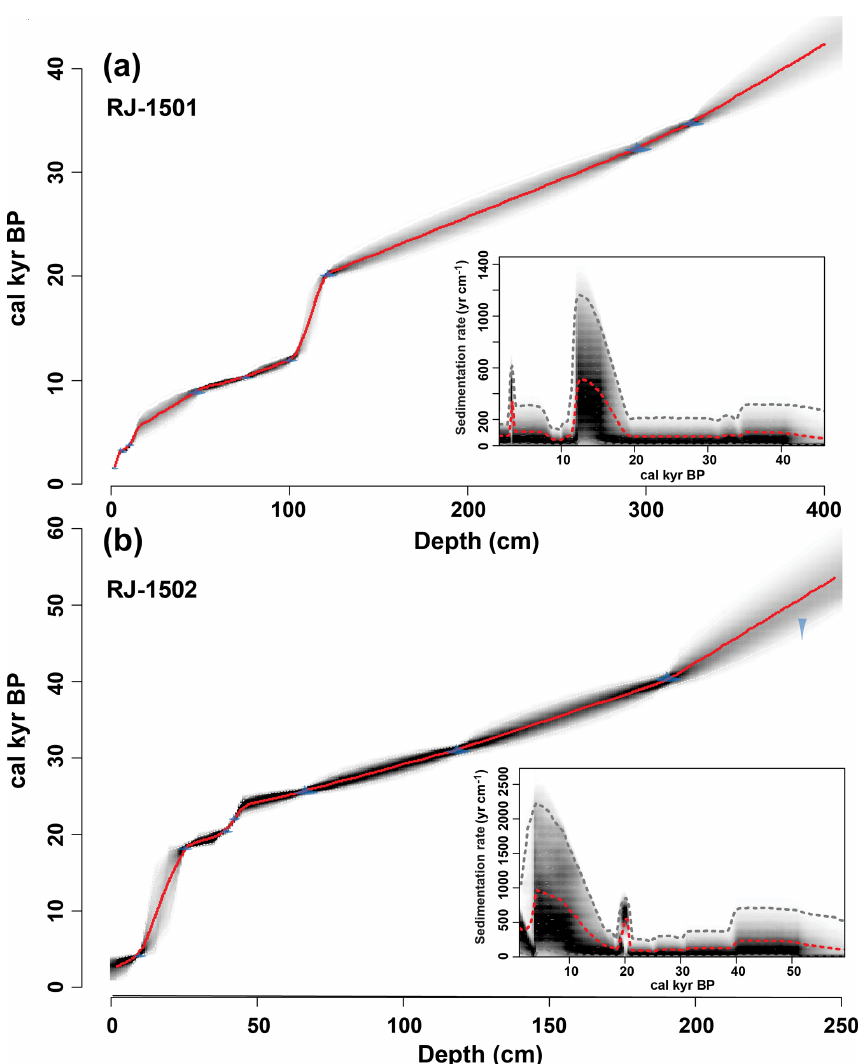
Figure 2. Bayesian age–depth model and sedimentation rate (yrcm − 1 ) for cores (a) RJ-1501 and (b) RJ-1502. The 14 C ages were calibrated with the curve IntCal13 (Reimer et al., 2013) and modeled with a reservoir age of 375 ± 36 years from 10 local records. Thick (larger panels) and dashed (smaller panels) red lines depicted the highest probabilistic model for the ages and accumulation rate, respectively. Dashed (smaller panels) grey lines indicated the upper and bottom limits of the accumulation